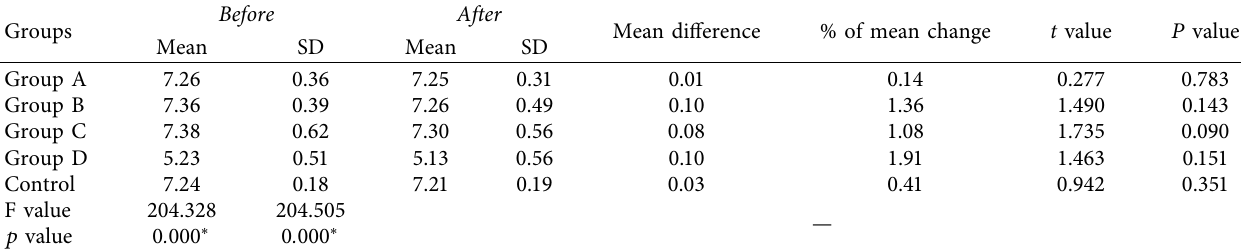
Table 1: Right side masseter muscle duration before and after treatment.